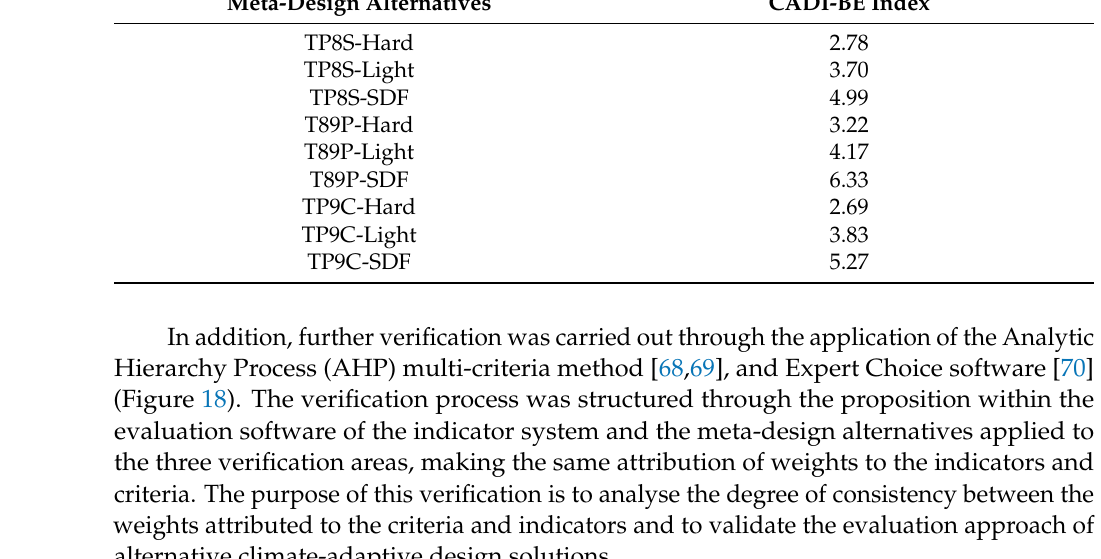
Table 5. Comparison of PMV average values: absolute reduction and percentage.